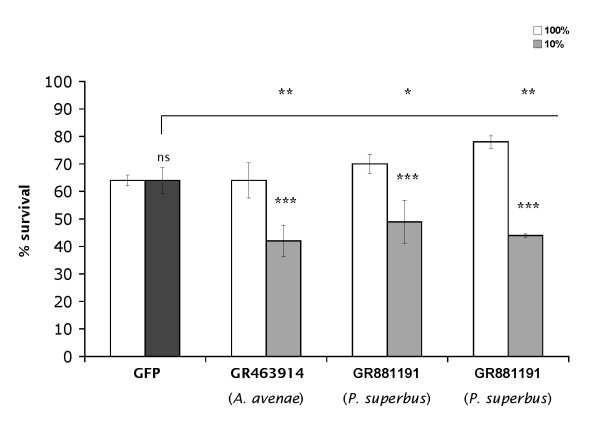
RNAi of cognate glutathione peroxidase transcripts in P. superbus reduces desiccation tolerance. Feeding of P. superbus with bacteria expressing dsRNA corresponding to A. avenae glutathione peroxidase sequence, GR463914, and P. superbus glutathione peroxidase sequences, GR881191 and GR881192, followed by assessment of desiccation tolerance. A bacterial feeder strain expressing dsRNA corresponding to GFP was used as a negative control. Mixed stage worms were subjected to desiccation at 10% RH for 24 h (negative control - black bar; other samples - grey bars). All samples were also subjected to mock desiccation at 100% RH (white bars). Mean values of triplicates, together with standard deviations, are shown; a one-way ANOVA with Tukey post-hoc test was performed: *, significance at P < 0.05; **, significance at P < 0.01; ***, significance at P < 0.001; ns, not significant.